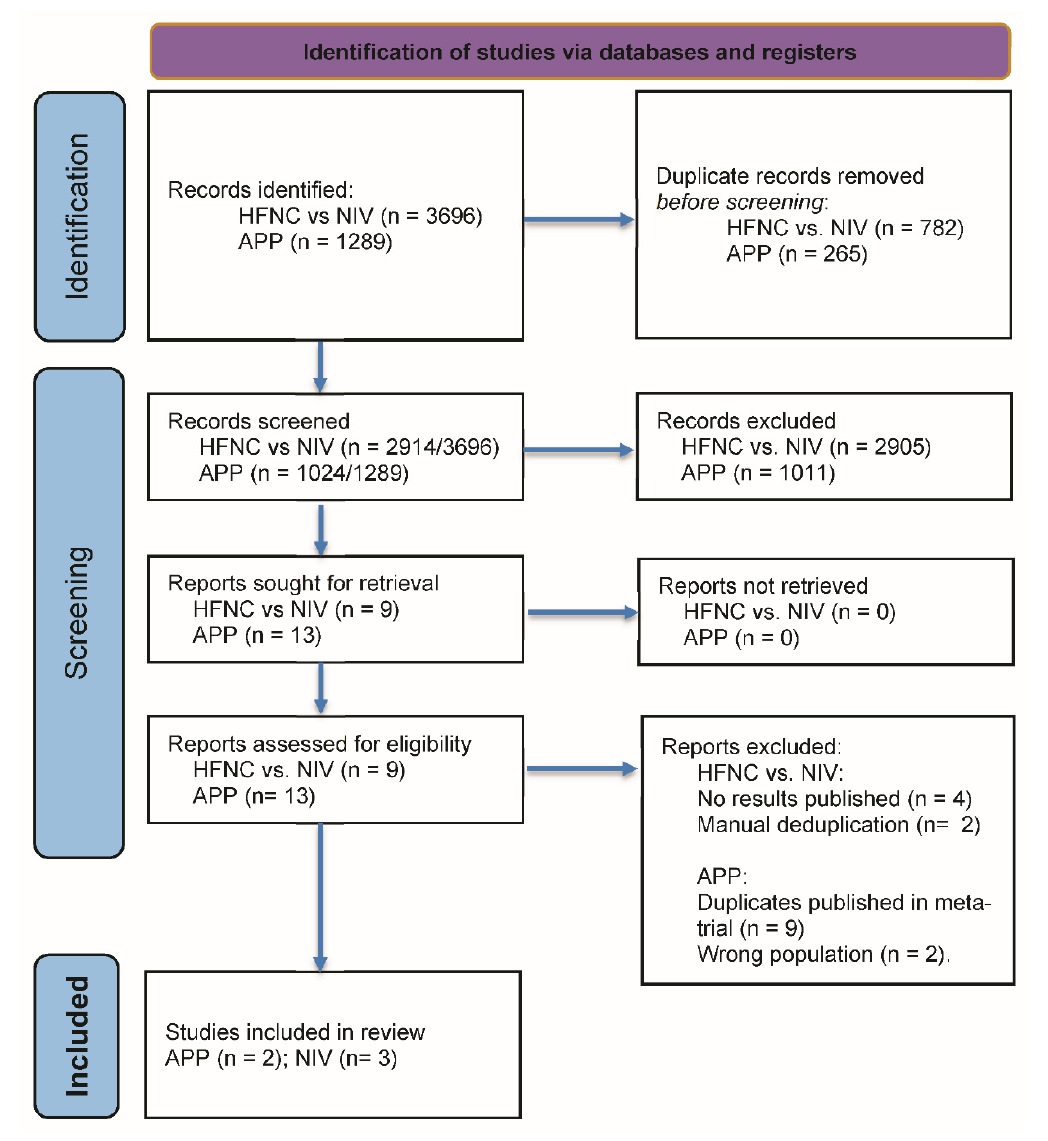
Figure 1. PRISMA flow diagram. HFNC: high-flow nasal cannula, NIV non-invasive ventilation, APP: awake prone-positioning; Adapted from: [24].